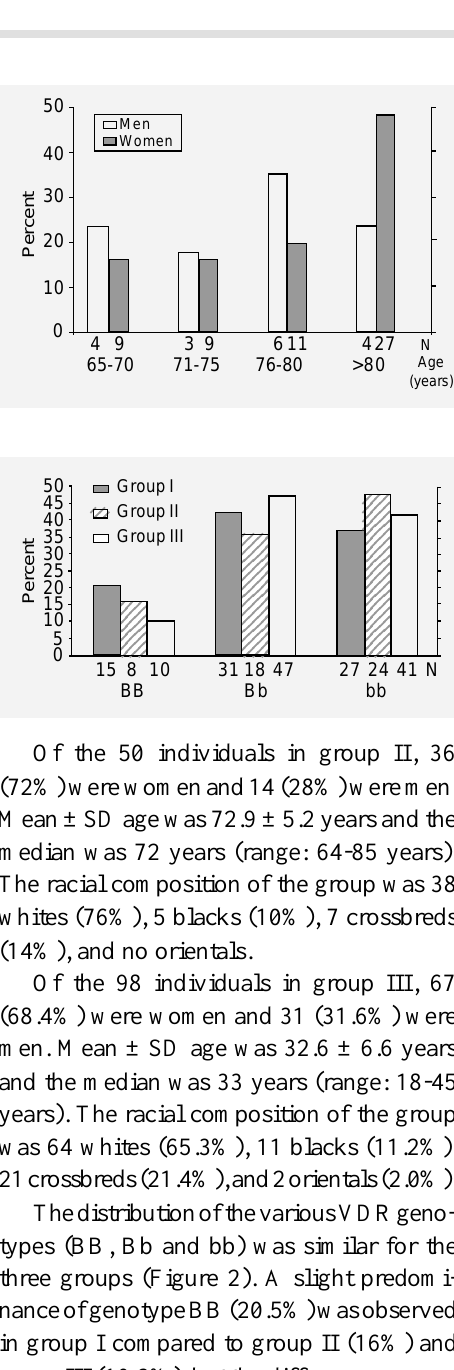
Figure 1 - Age and sex distribu- tion of the patients with fracture of the proximal femur.